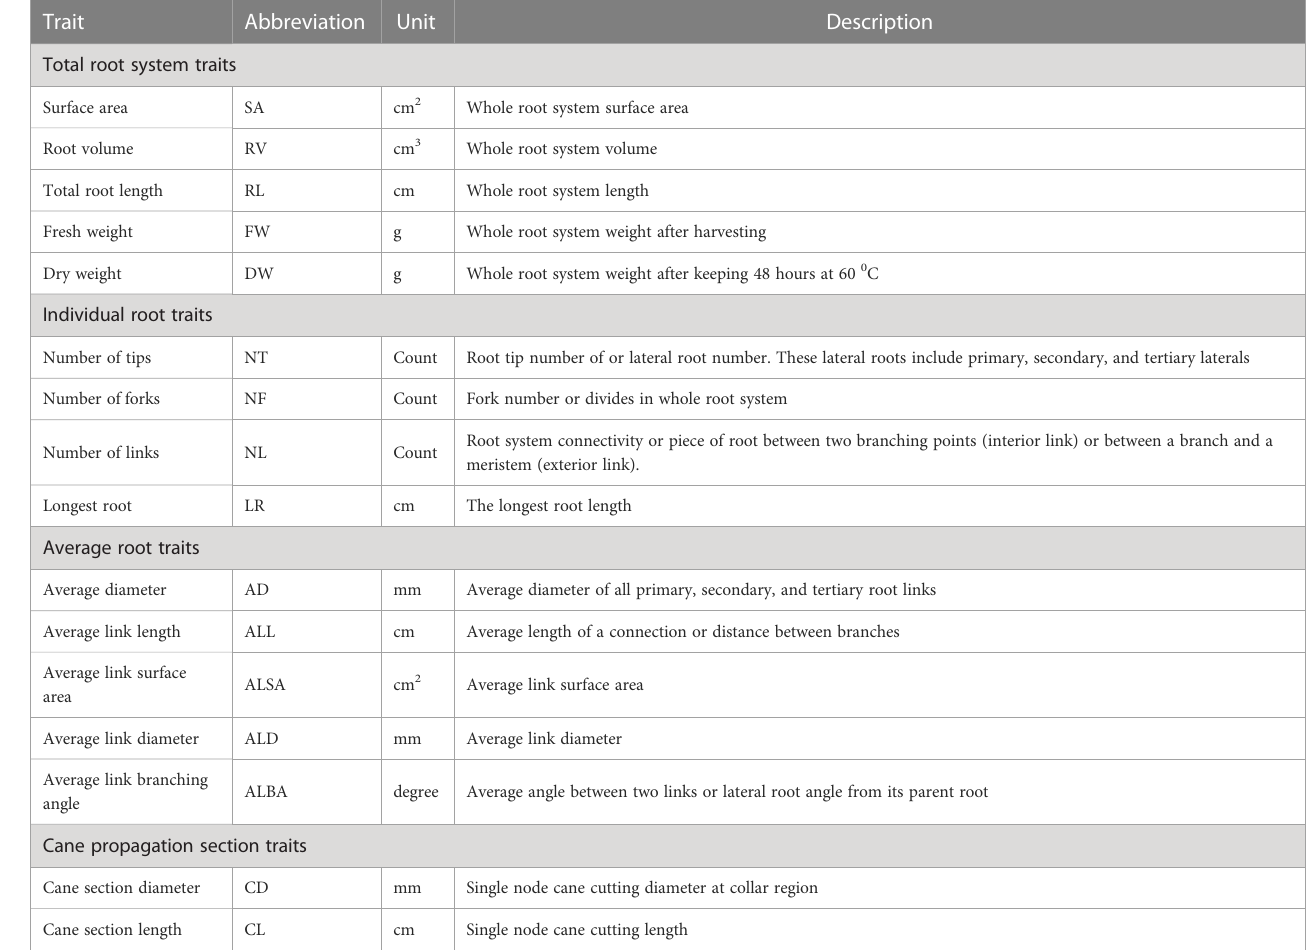
TABLE 1 Root system architecture trait abbreviations and measurement